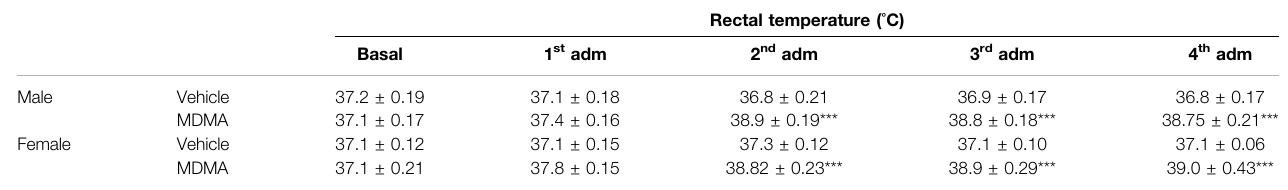
TABLE2| EffectsoftreatmentwithMDMAonbodytemperatureinmice.Adultmaleandfemalemice(N (cid:2) 6pergroup)weretreatedwitheitherMDMA(4 × 20 mg/kg,i.p.,2 h apart) or vehicle (saline solution, i.p.). Body temperature values are reported as mean ± S.E.M. *** p < 0.001 compared with the respective group of vehicle-treated mice by Newman-Keuls post-hoc